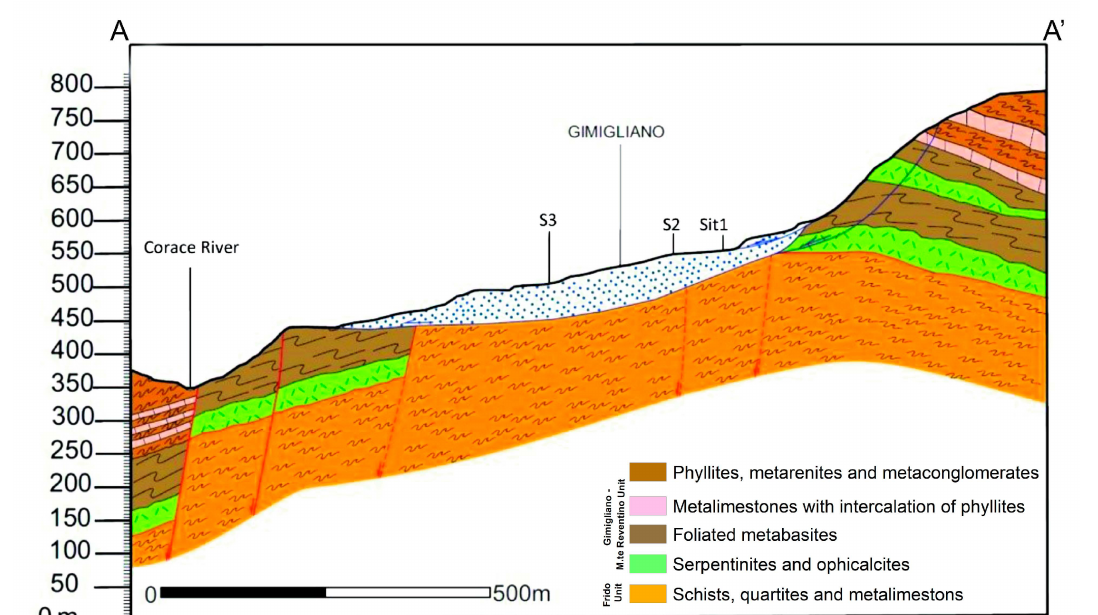
Figure 5. Geological cross-section along the longitudinal A-A’ trace (Figure 3). The 2D geological- structural model is the result of the field survey, borehole stratigraphies, and ERT